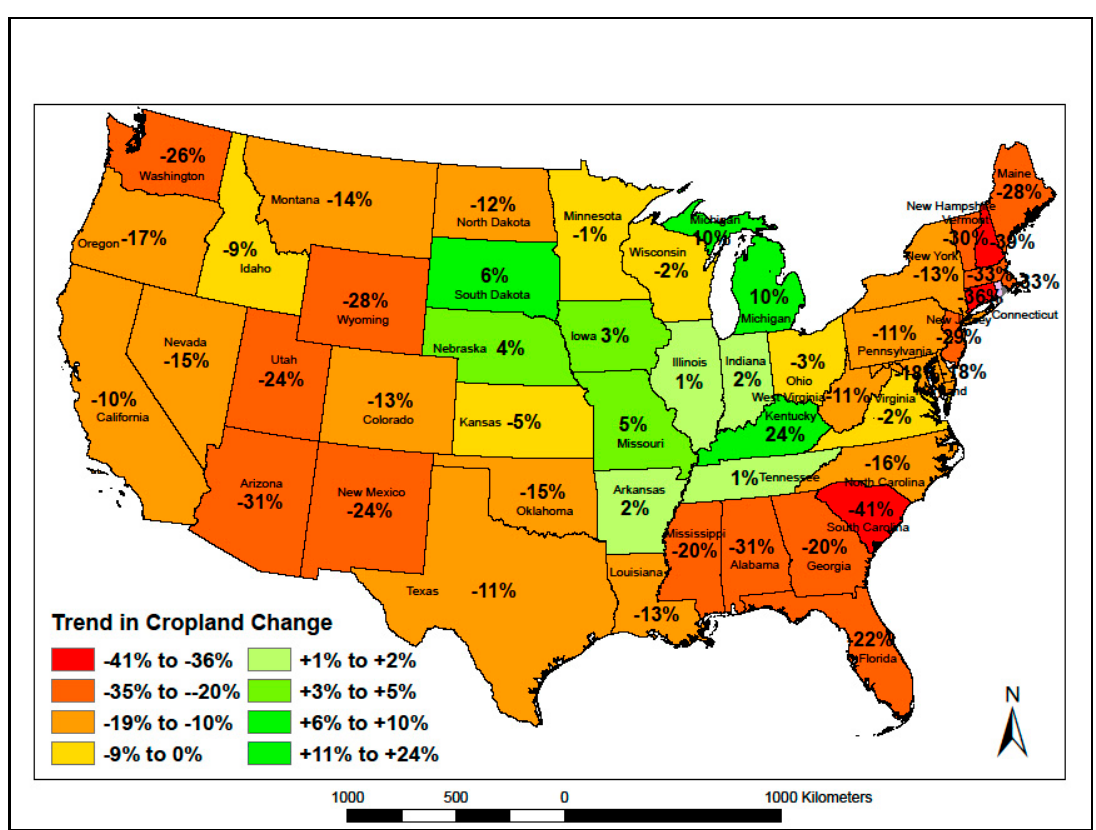
Figure 2. Trends in cropland from 1974 to 2012 by states, according to the USDA Major Land Uses Dataset (map created by author). Positive percentages indicate more cropland.